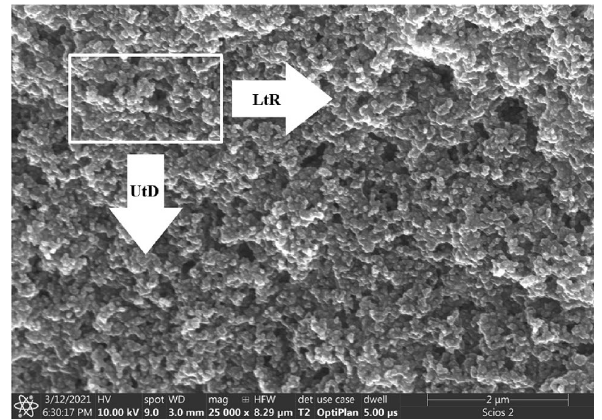
Figure 8. Scheme of the imaging process during SEM observations (sample B